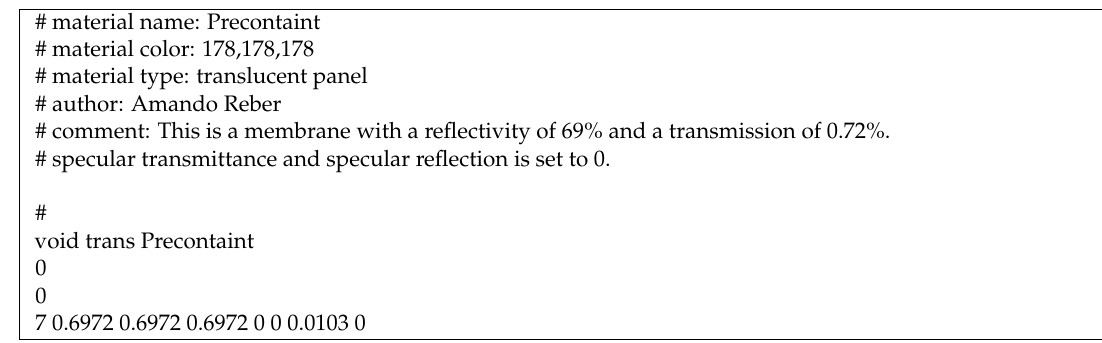
Table A3. Material configuration file of DIVA.